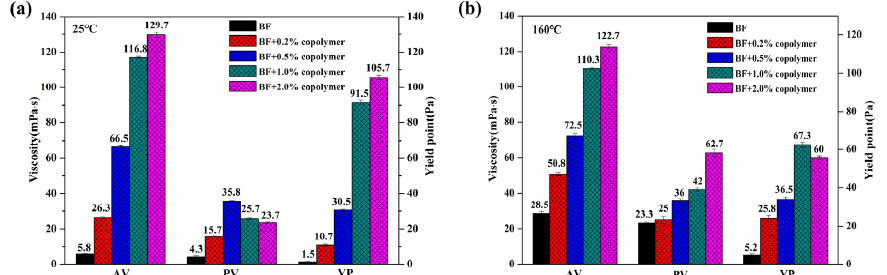
Figure 6. Rheological properties of drilling fluids with different concentrations of copolymer before ( a ) and after hot rolling ( b ).